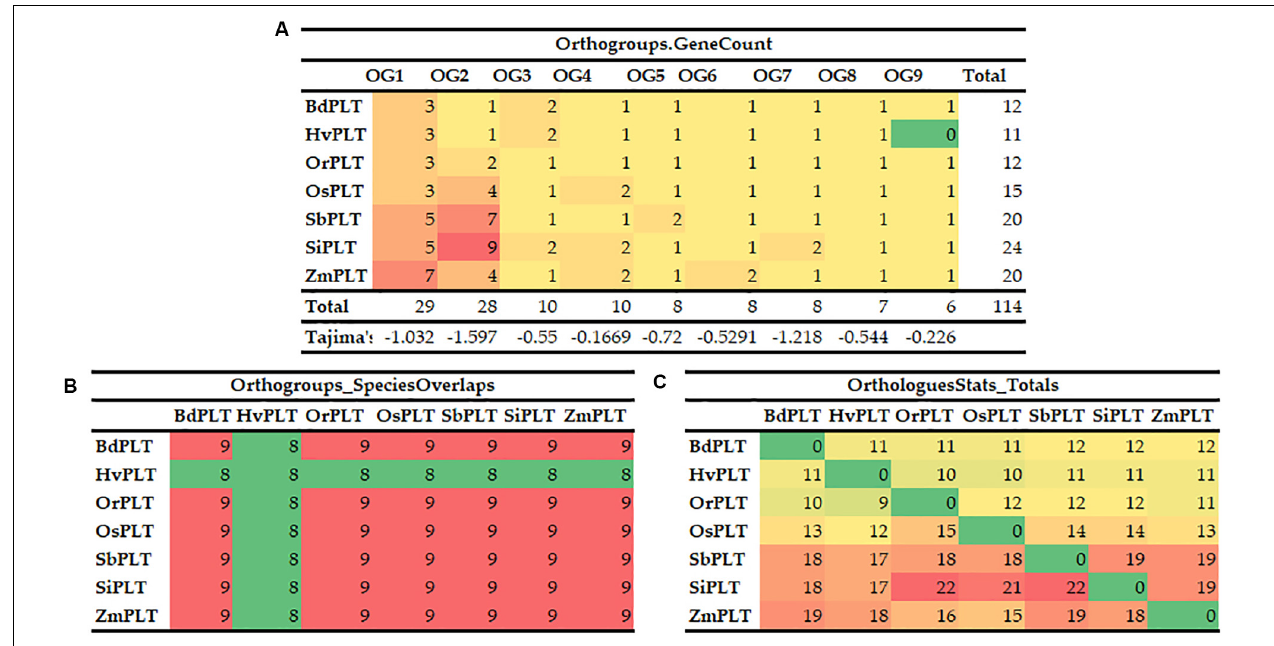
FIGURE 2 | Orthogroups of PLT genes among the seven Gramineae crops, namely, BdPLT, HvPLT, OrPLT, OsPLT, SbPLT, SiPLT, and ZmPLT. Orthogroup overlaps (A) , statistical results of orthologous genes between different crops (B) , and gene counts and Tajima’s values of different orthogroups in these seven crops (C) .